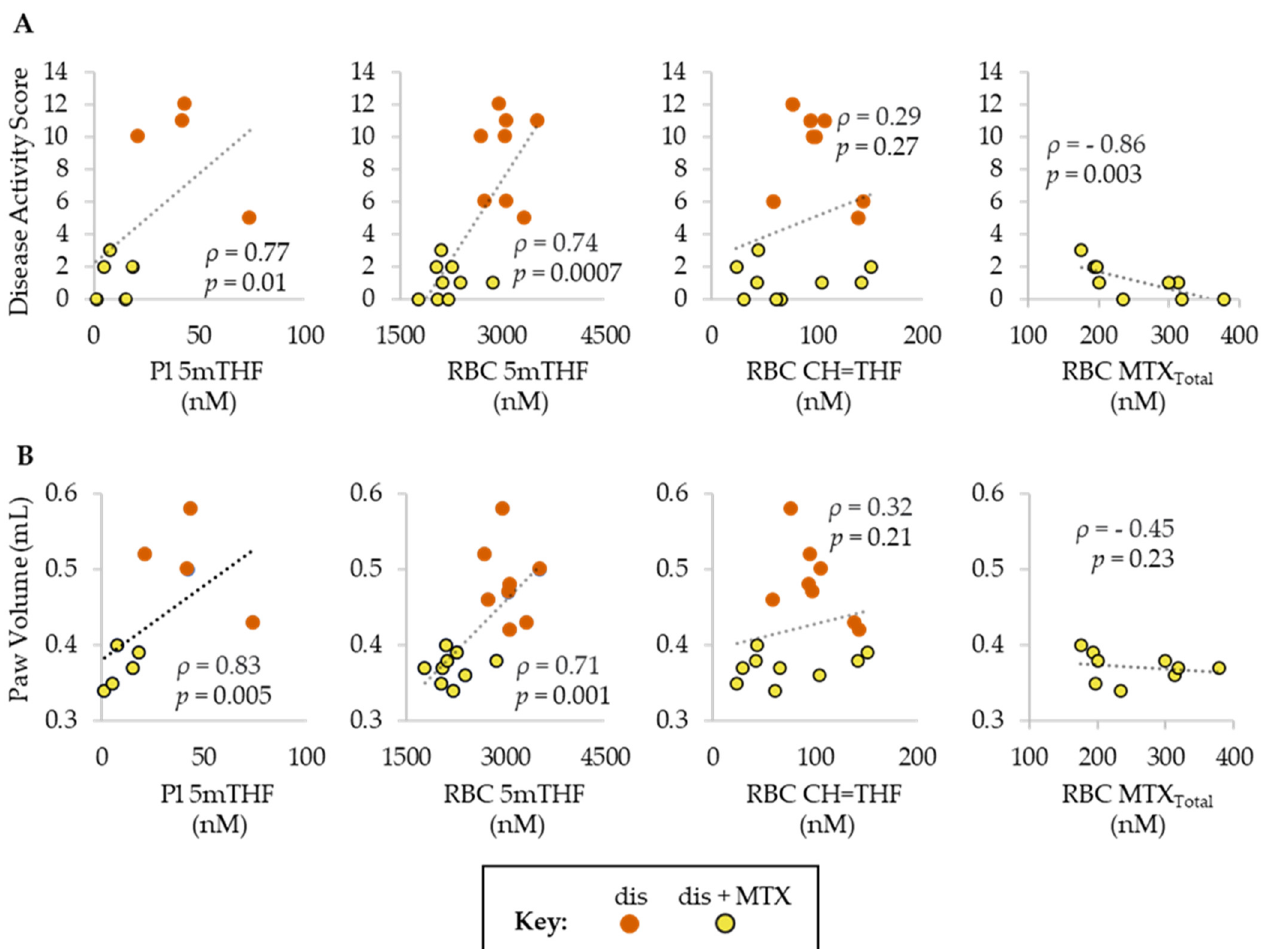
Figure 3. Spearman’s correlations of ( A ) DAS and ( B ) PV with folate (5mTHF and CH=THF) and MTX (MTX Total ) levels in plasma and/or RBCs. Groups include, dis (orange; n = 8) and dis + MTX (yellow; n = 9).